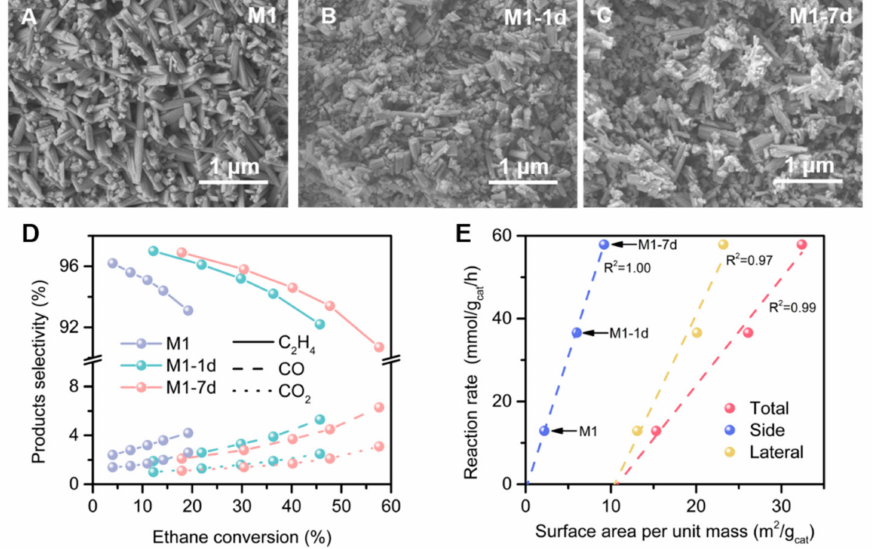
Figure 10. M1 catalysts with different specific surface areas, particle sizes, and aspect ratios after water agitation treatment for several days ( A – E ). Adapted from ref. [18], Copyright (2022), with permission from Elsevier.